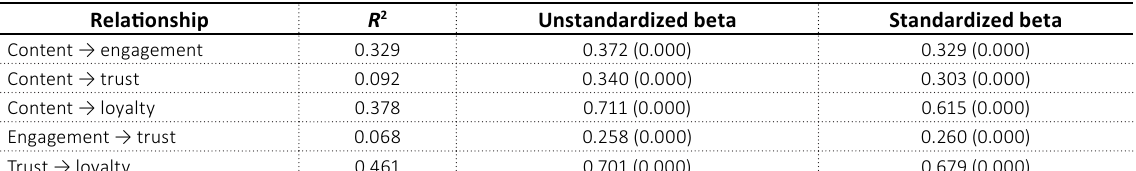
Table 5. Estimated